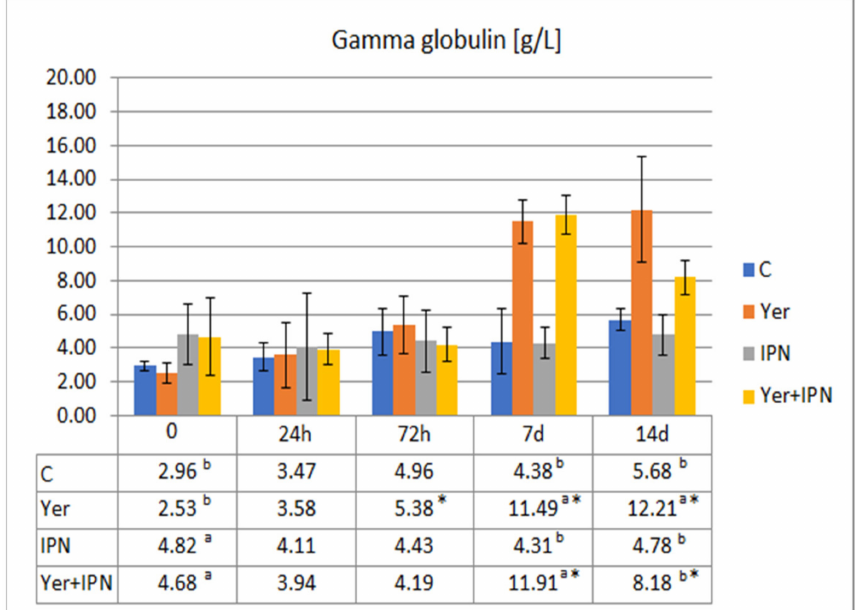
Figure 12. Mean values and standard deviation of gamma globulin levels over the course of the second experimental infection. *—statistically significant differences compared to the day 0 values within a given group ( p ≤ 0.05); a, b —statistically significant differences between the groups on a given sampling day ( p ≤ 0.05).